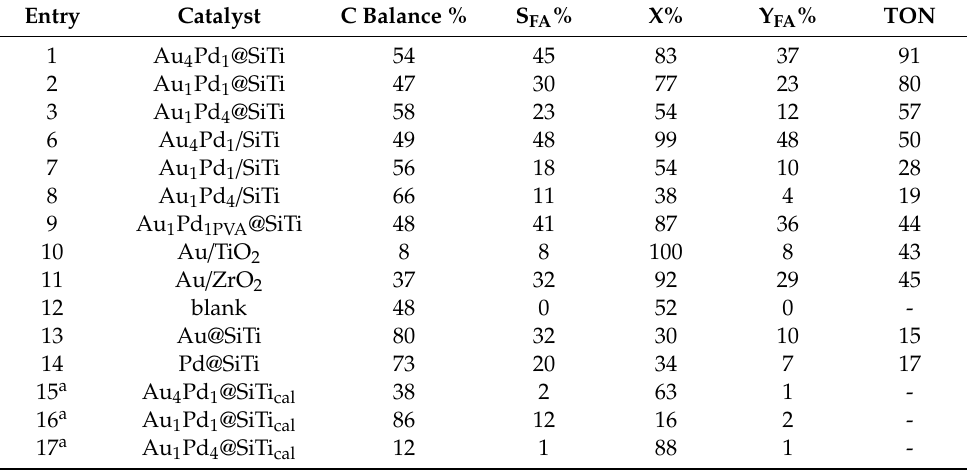
Table 4. Oxidation of furfural in the absence of a base for 10 h using embedded Au x Pd y @SiTi and supported Au x Pd y / SiTi, Au / TiO 2 , Au / ZrO 2 catalysts. (Conditions: Aqueous solution of